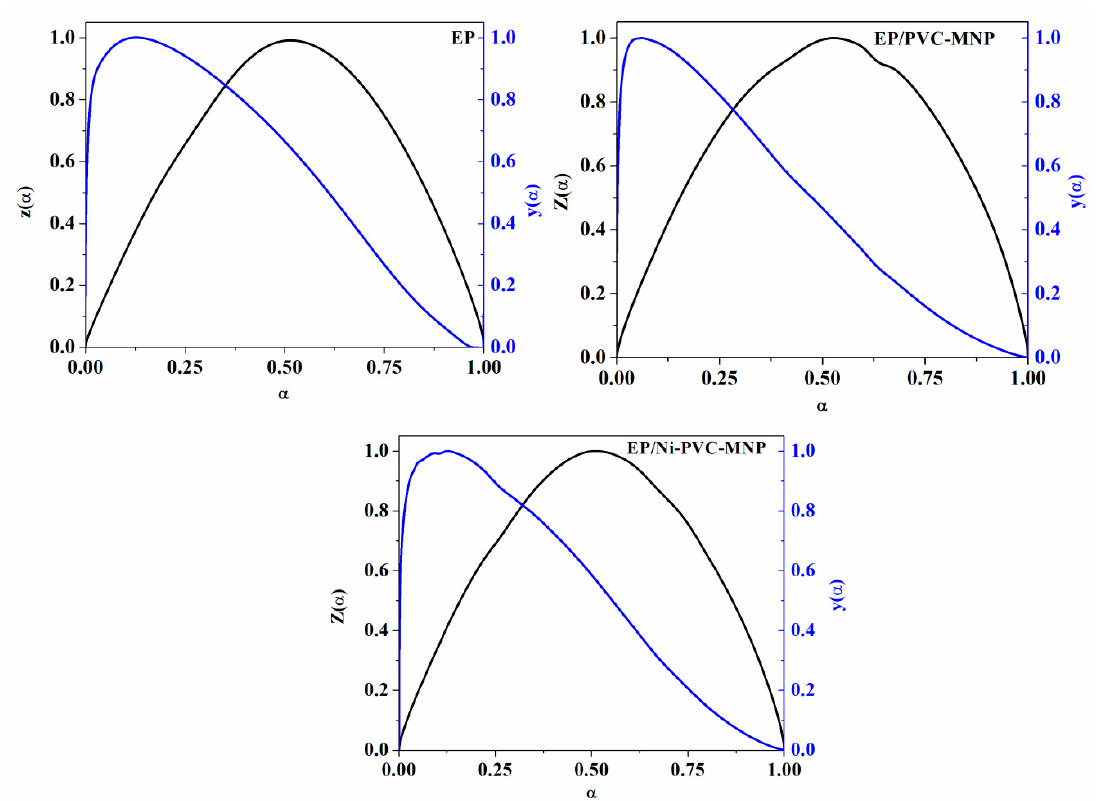
Figure 10. Values of Malek parameters (y( α ) and Z( α )) as a function of the extent of cure, α .